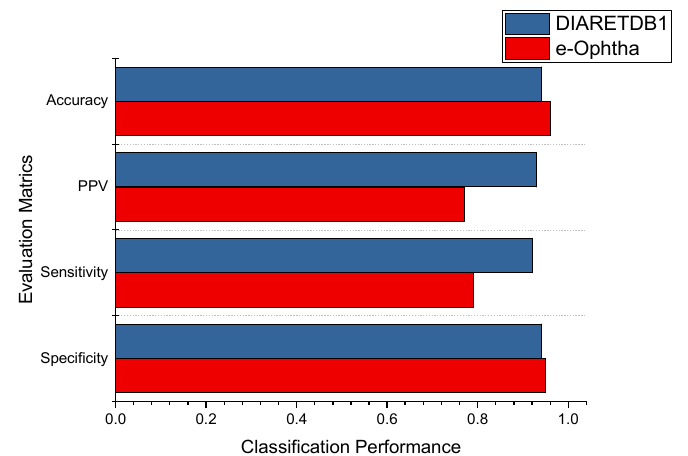
Figure 11. The performance evaluation of the proposed method using both datasets. Table 3. Overall microaneurysms classification performance of the proposed approach against lit ‐ erature study.